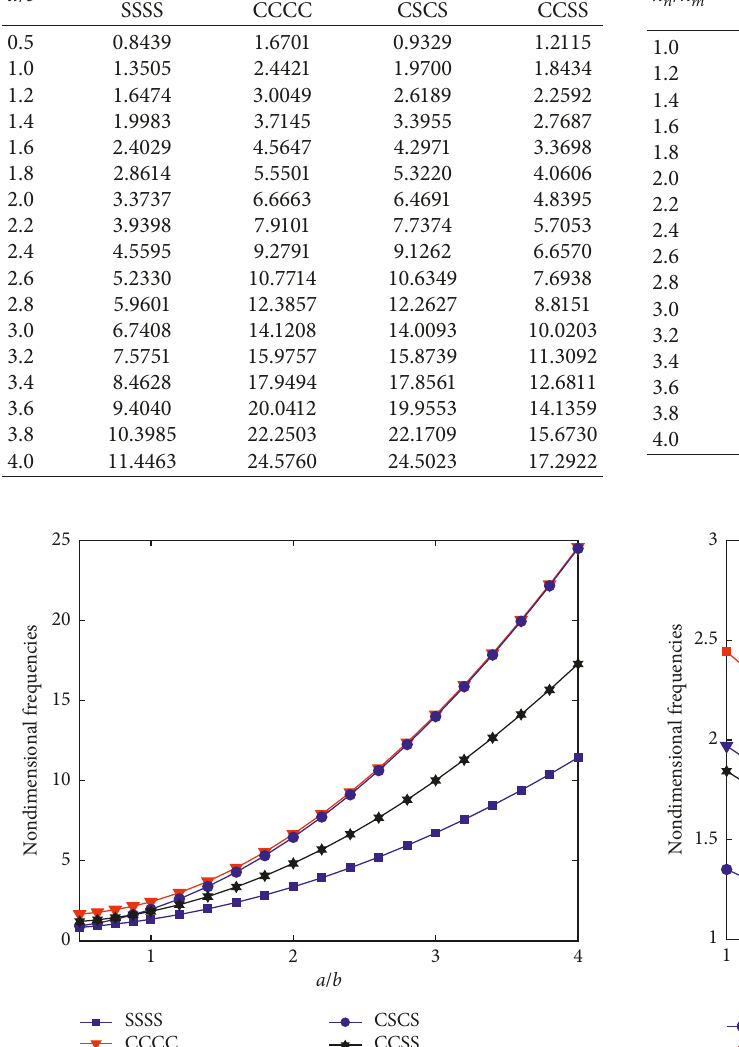
Table 10: Influence of ratio h frequency of the square plate with a / b � 1 and k